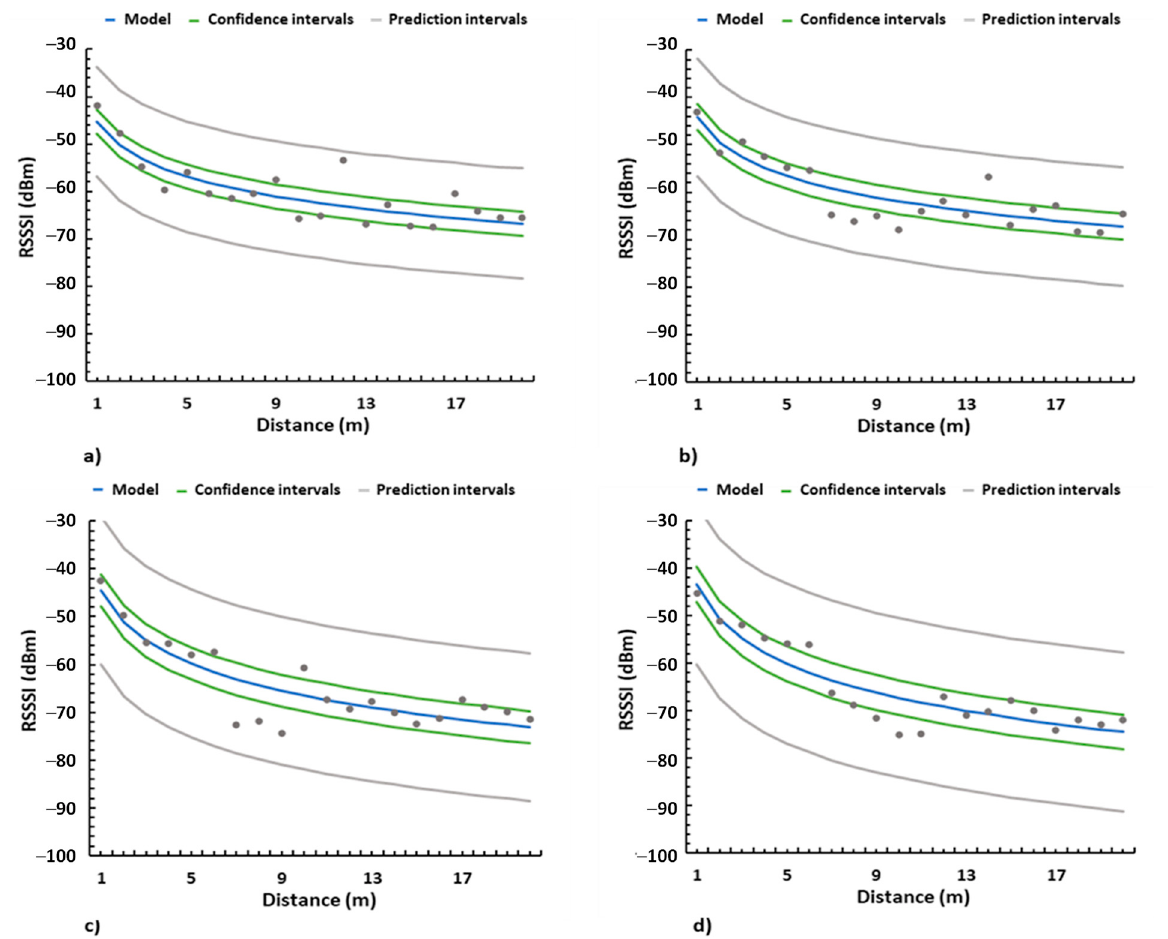
Figure 18. Heuristic model for ( a ) emitter at height of 0.5 m, ( b ) emitter at height of 1 m, ( c ) emitter at height of 1.5 m, and ( d ) emitter at height of 2 m.